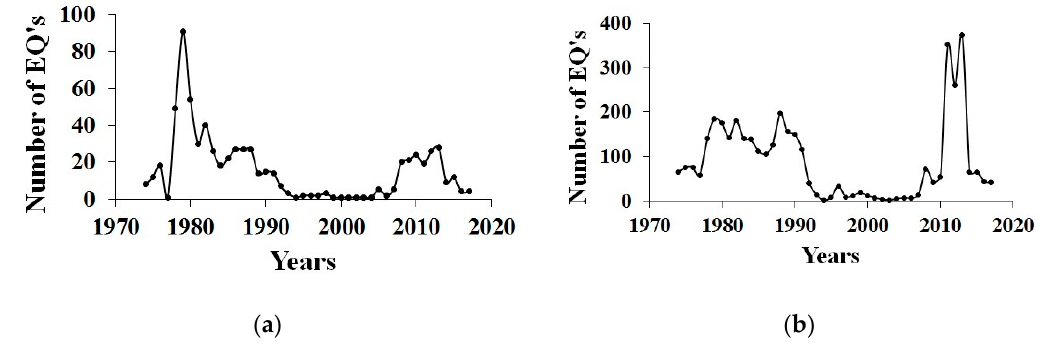
Figure 5. EQ number versus time in the near and larger zone: ( a ) EQ number—all events, including M < 2.2 in the near zone, R = 50 km; ( b ) EQ number—all events, including M < 2.2 in the large zone, R = 100